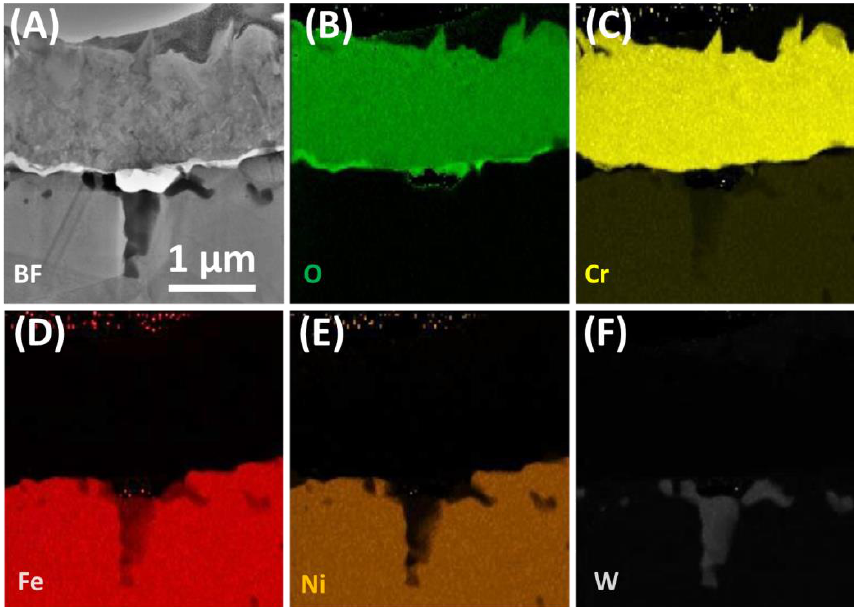
Figure 7. Oxide scale, grown on Sanicro 25 surface after 500 h of oxidation in steam at 700 °C: ( A ) STEM-BF image, ( B )–( F ) STEM-EDS elemental maps of selected elements.